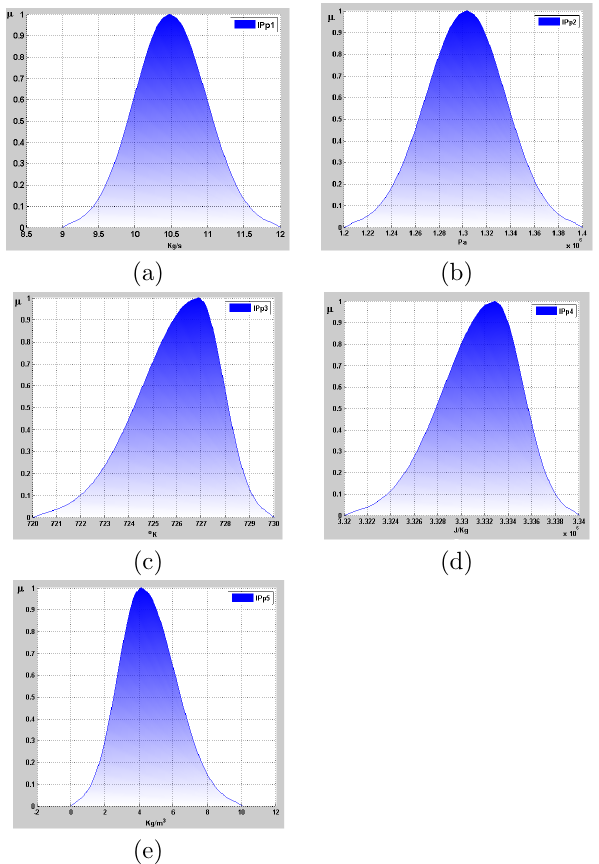
Figure 3. Fuzzy input parameters of intermediate-pressure section of a steam turbine system (a) p 1 (Inlet steam flow from boiler superheat section), (b) p 2 (Inlet steam pressure), (c) p 3 (Inlet steam flow temperature), (d) p 4 (Inlet steam flow enthalpy) and (e) p 5 (Inlet steam flow